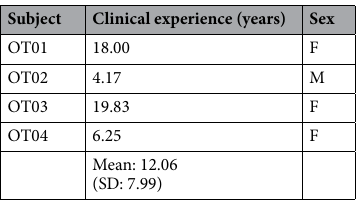
Table 1. The demographic characteristics of the certified occupational therapists. Abbreviations: F, female; M, male; SD, standard deviation.